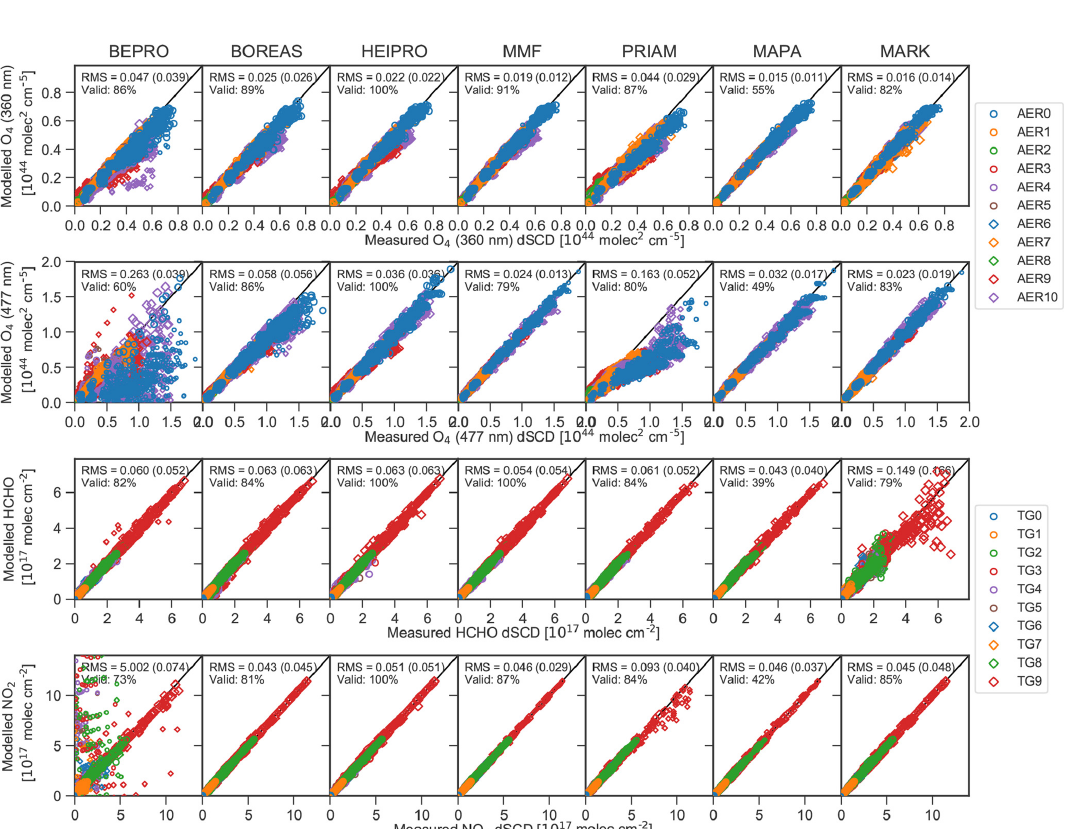
Figure 9. A posteriori versus measured dSCDs of O 4 (360 and 477nm), HCHO, and NO 2 for the v1n dataset. Colours and symbols indicate the underlying aerosol and trace gas profiles, respectively, as denoted in the legend. Data flagged as invalid are shown as smaller symbols. Also shown are the RMS differences between measured and modelled dSCDs with the RMS for valid data only being shown in brackets, as well as the percentage of valid data. Units of the RMS are 10 44 molec 2 cm − 5 for O 4 and 10 17 moleccm − 2 for HCHO and NO 2